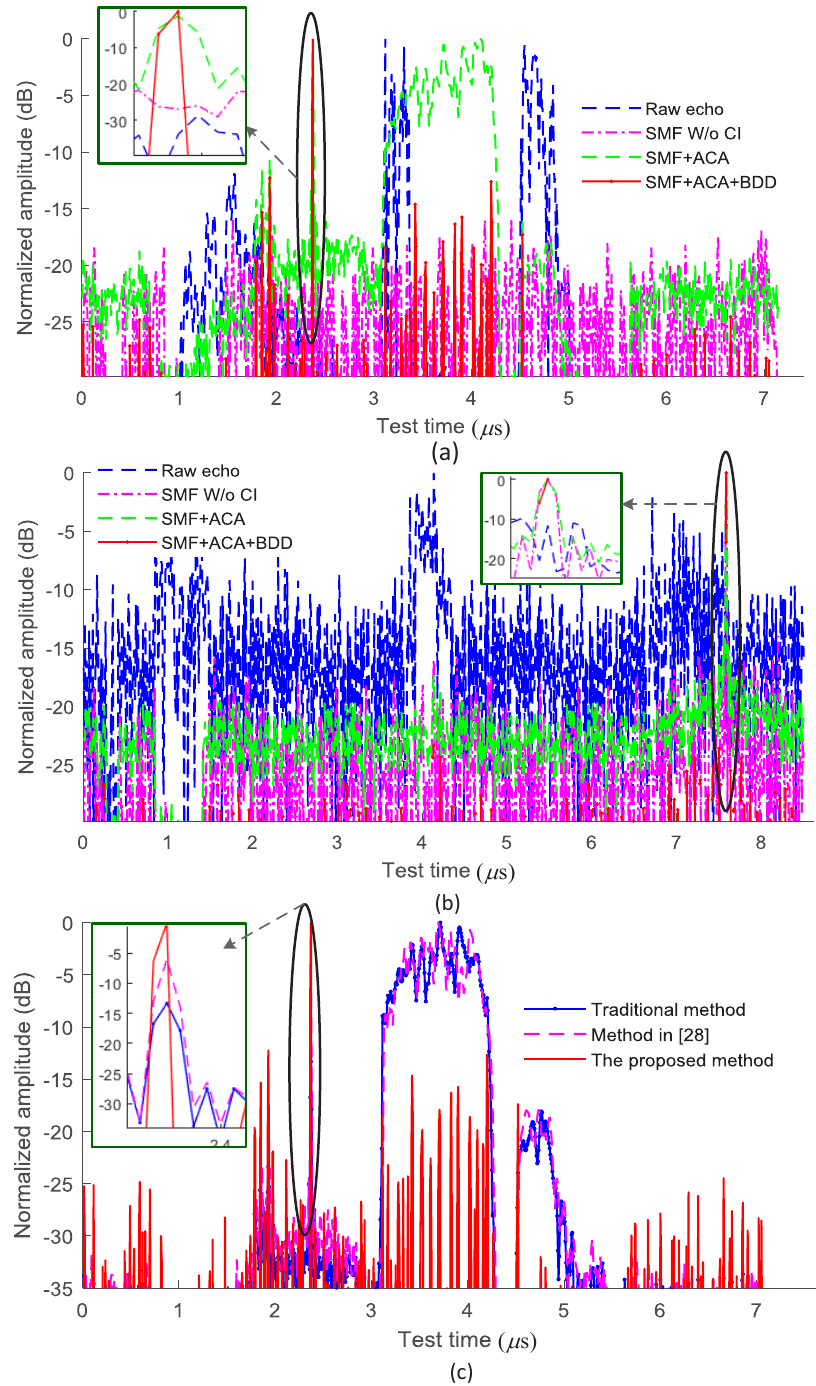
Figure 7. The performance of the proposed method based on the experimental data. ( a ) The result for Scenarios 1; ( b ) The result for Scenarios 2; ( c ) Comparison between the traditional method, the method in [28] and the proposed method for Scenario